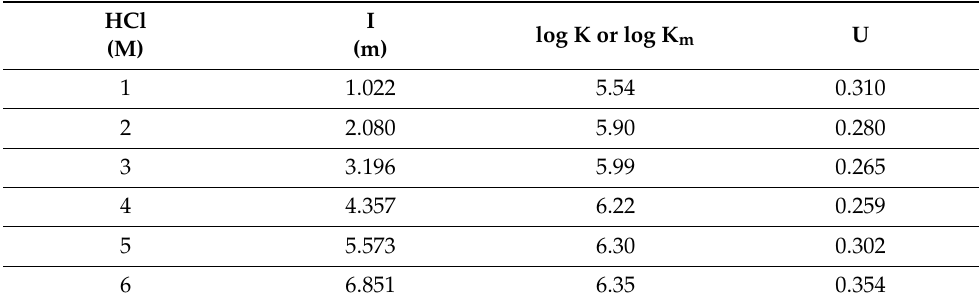
Table 3. Variation of log K (log K m ) at different I values.